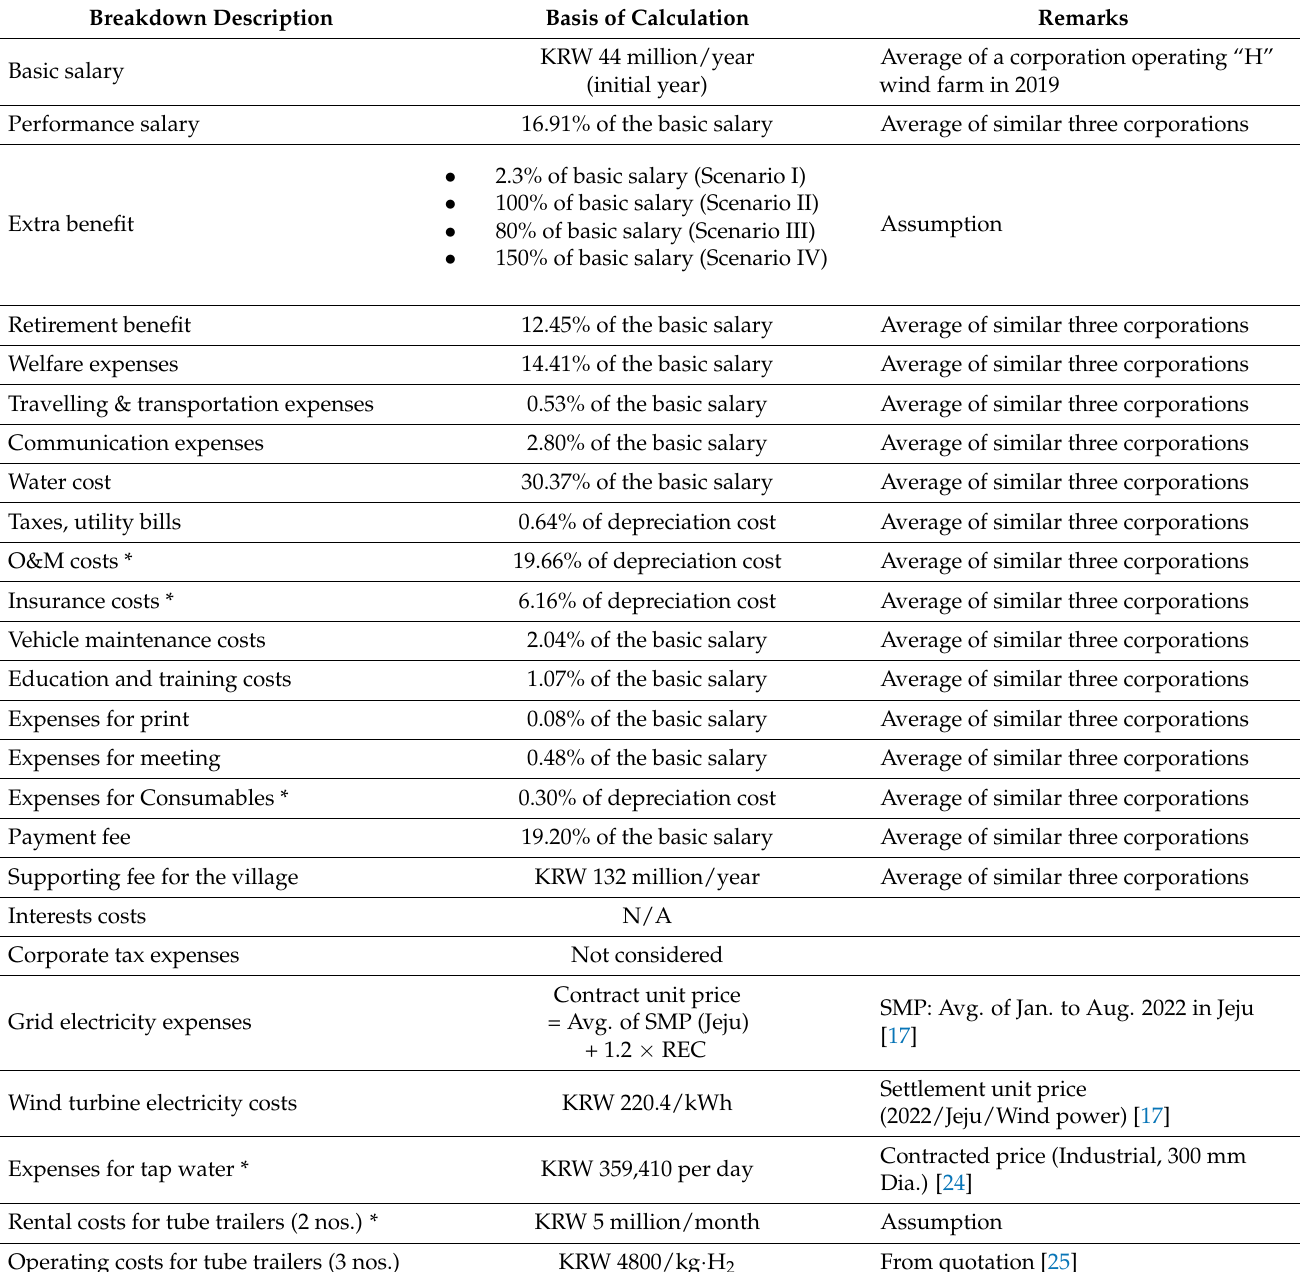
Table 8. Breakdown and basis of calculation for respective items for